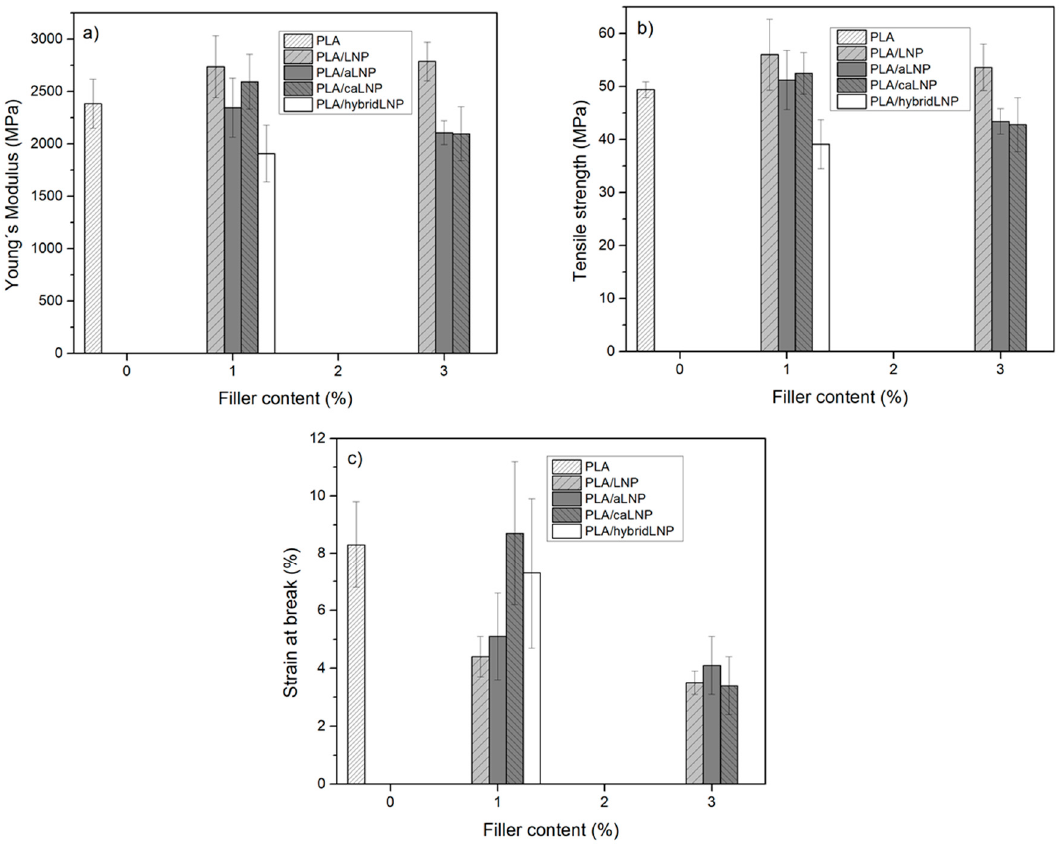
Figure 3. Tensile properties of PLA and PLA nanocomposite films: ( a ) Young’s modulus; ( b ) tensile strength and ( c ) strain at break.